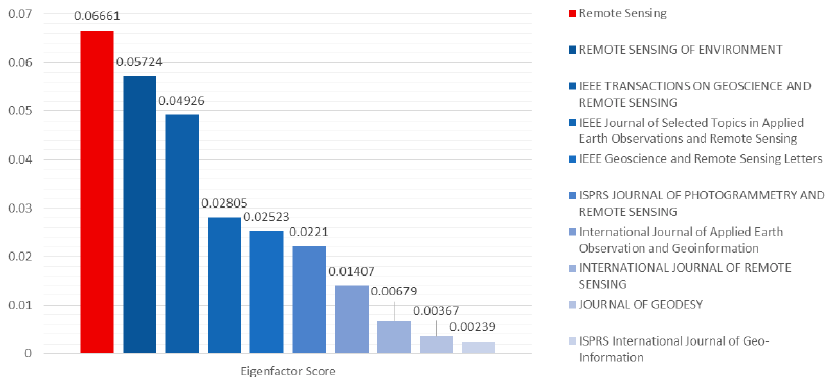
Figure 8. The top 10 journals under the category “Remote Sensing” based on Eigenfactor score (2019). Data were calculated from Web of Science on 13 July 2020.